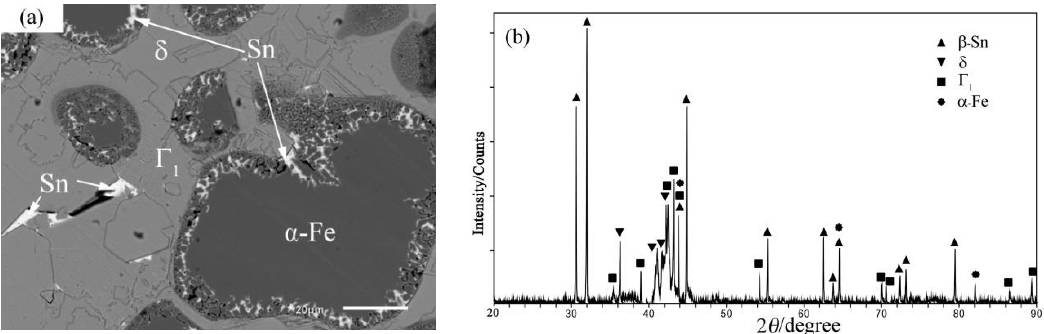
Figure 7. The microstructure ( a ) and XRD pattern ( b ) of Alloy A9.